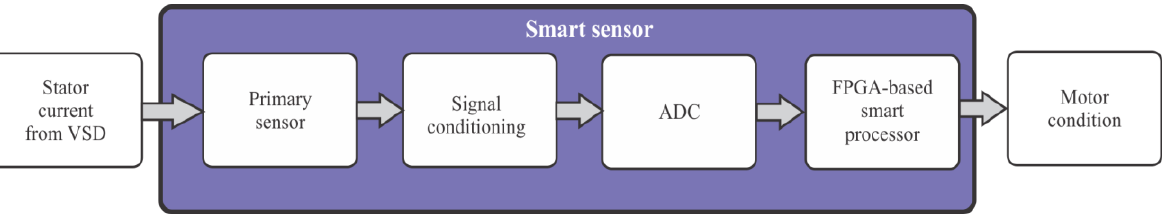
Figure 4. Block diagram of the fault detector smart